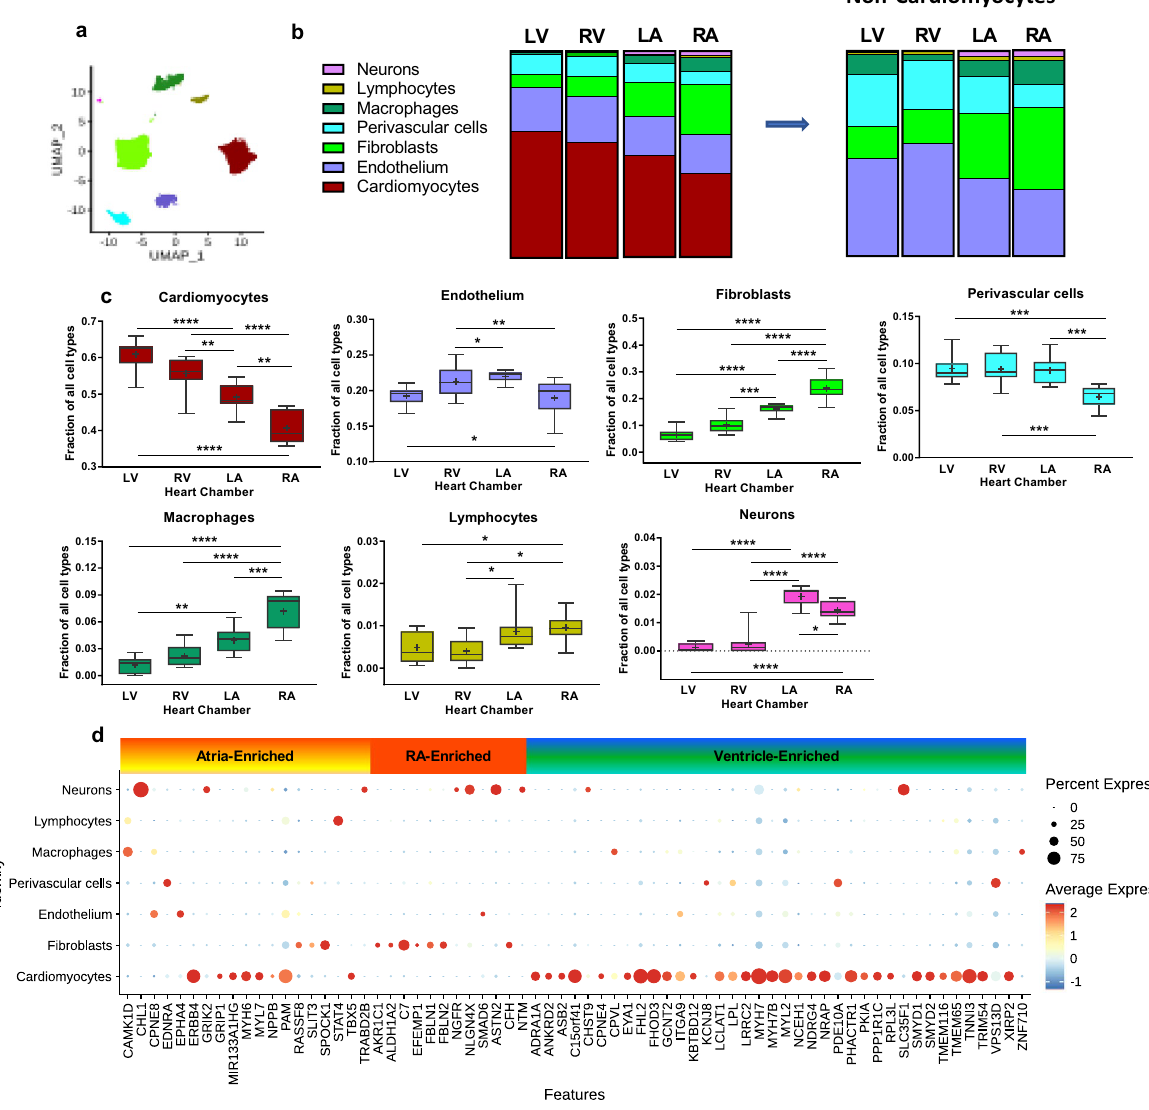
Figure 3. Non-failing human hearts display a regional and cellular specific transcriptome landscape. ( a ) UMAP (Uniform Manifold Approximation and Projection) projection of major cell types in NF human heart identified by single nucleus RNA-Seq (n = 7535 nuclei). Each dot represents a single nucleus, different cell type clusters are color-coded. ( b ) Cellular composition (“part-of-whole” bars) and ( c ) fractions of each cell type in each chamber of human non-failing hearts (box plots) by SCDC deconvolution analysis. Asterisks indicate the significance between the chambers by one way ANOVA followed by Tukey post-test (* p < 0.05, ** p < 0.01, *** p < 0.005, **** p < 0.001) ( d ) Cell-type-specific gene expression distribution of Heart and Subregion-Enriched genes in non-failing heart. The size of the dot indicates the percentage of cells with at least one transcript detected and the color of dot represents the scaled average expression level of expressing